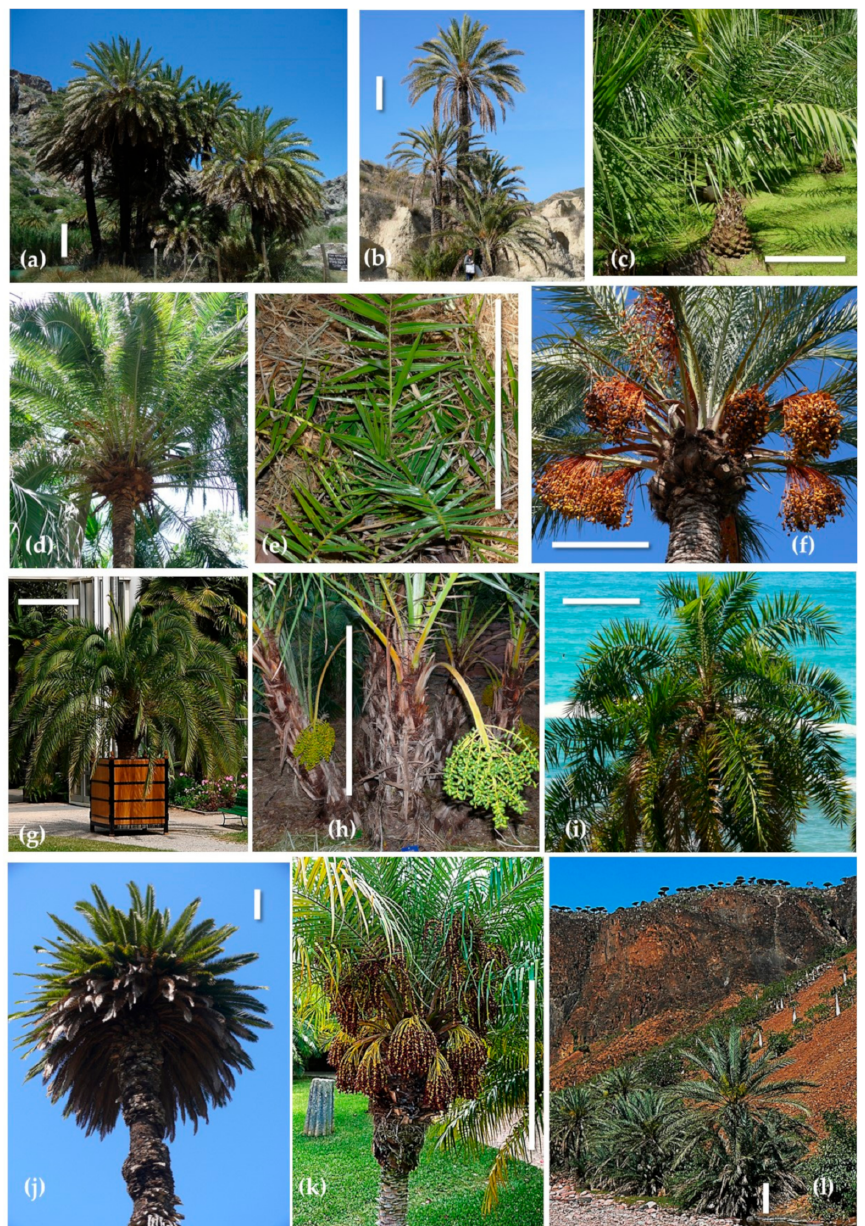
Figure 1. Diversity of Phoenix: palm trees. ( a ), Phoenix theophrasti (Preveli, Crete, Greece); ( b ), P. iberica (Abanilla, Spain); ( c ), P. loureiroi Manipur (Huerto del Cura, Elche, Spain); ( d ), P. rupicola (Jard í n Bot á nico de Valencia, Spain); ( e ) P. farinifera (Colecci ó n Tom á s-Font, Valencia, Spain) ( f ), P. dactylifera “Candits” Western Group (W_DAC) (Elche, Spain); ( g ), P. canariensis var. canariensis (Geneva, Switzerland); ( h ), P. reclinata (Jard í n Bot á nico La Concepci ó n, M á laga, Spain); ( i ), P. pusilla (Menton, France); ( j ), P. canariensis var. porphyrococca (Lisboa, Portugal); ( k ), P. roebelenii (Orihuela, Spain); ( l ), P. dactylifera “Sarafana” Eastern Group (E_DAC) (Socotra, Yemen). Abbreviations for the major P. dactylifera geographical groups: E_DAC: North Africa and West Asia P. dactylifera. W_DAC: North Africa and Mediterranean P. dactylifera. Scale bar: 1 m. Images: ( a ). Jorge S á nchez-Balibrea. ( b – d , j ). Diego Rivera and Concepci ó n Ob ó n, ( l ). Joel